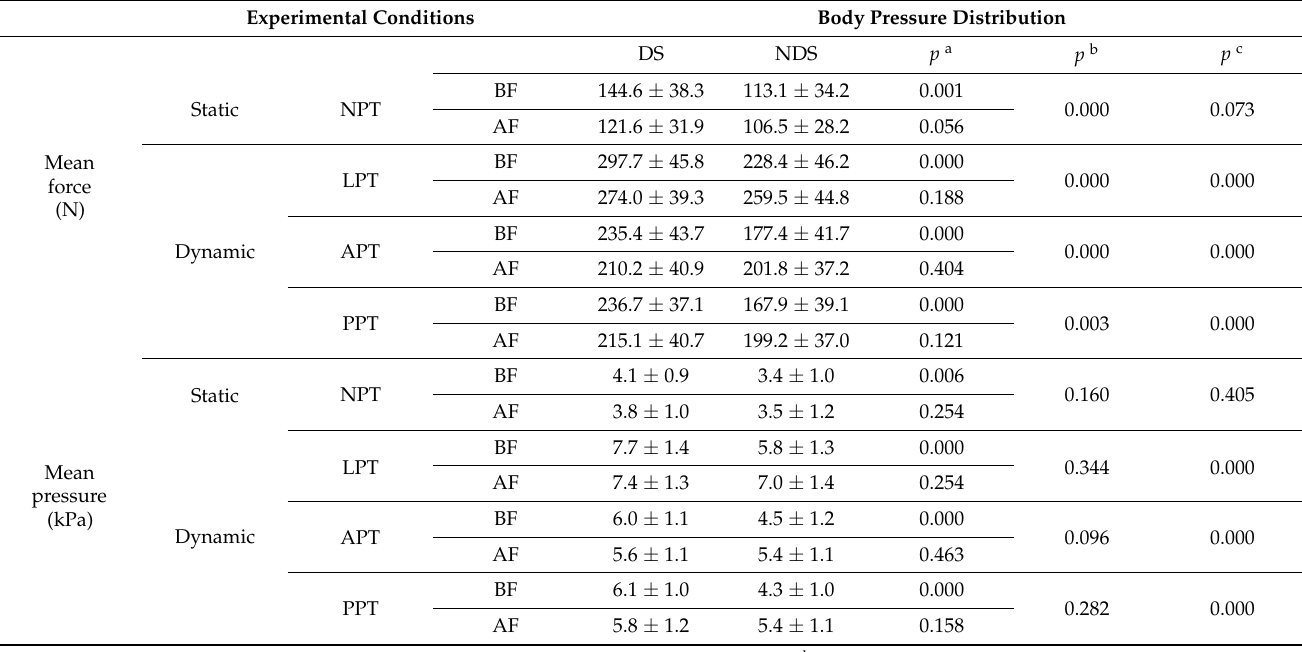
Table 1. Differences in body pressure distribution on the dominant side (DS) and non-dominant side (NDS) between before (BF) and after (AF) performing the exercise under four conditions: no pelvic tilt (NPT), lateral pelvic tilt (LPT), anterior pelvic tilt (APT), and posterior pelvic tilt